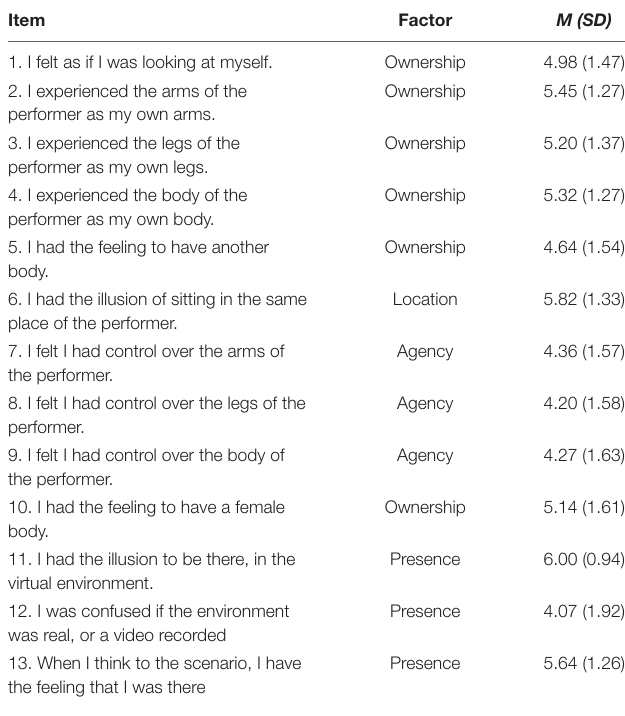
TABLE 2 | Descriptive statistics for each item on the embodiment and sense of presence scales ( N =